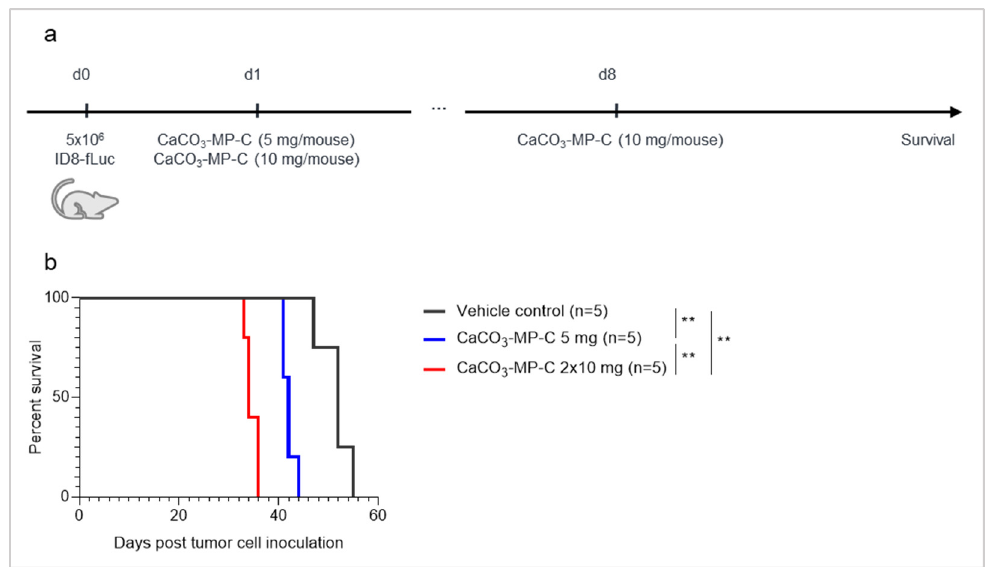
Figure 5. Experimental set-up of the experiment ( a ) with corresponding Kaplan–Meier survival curve ( b ) of mice injected with vehicle control, a single injection of 5 mg of CaCO 3 -MP-C on day 1 or a repeated injection of 10 mg of CaCO 3 -MP-C on day 1 and 8 post tumor cell inoculation. ( b ): A repeated dose of 2 × 10 mg of CaCO 3 -MP-C worsens survival compared with a single dose of 5 mg ( p adj = 0.0062), indicating a dose-dependent effect. Degree of significance: p adj < 0.01 (**).